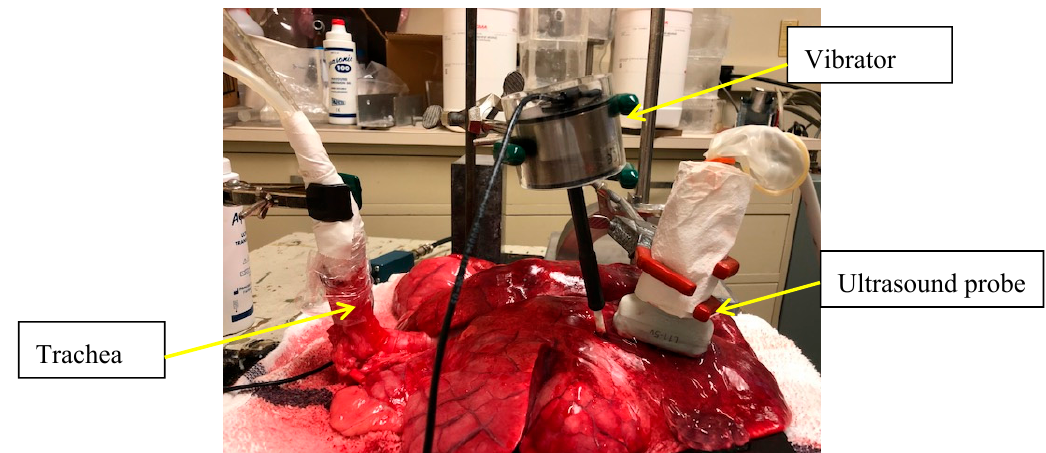
Figure 1. Experimental design for testing the surface wave speed on an ex vivo fresh swine lung. The swine lung was tested on a table. A thick rubber pad was placed between the lung and the table to reduce wave reflection. The water was injected into the lung through a plastic tube connected to the trachea of lung. In this ex vivo swine lung study, the surface wave propagation was generated using a small vibrator and measured using an ultrasound probe.